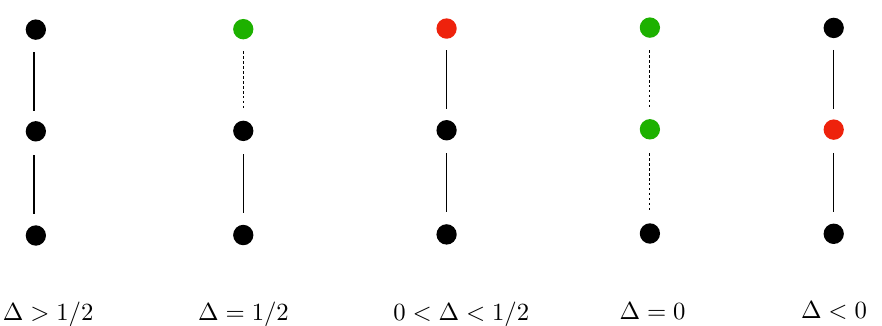
multiplets, for the various (cid:1)